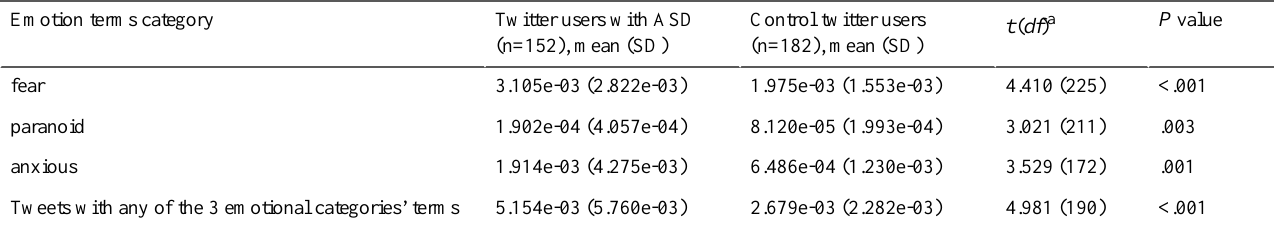
Table 4. Tweets containing emotion-related keywords among Twitter users with autism spectrum disorder (ASD) and control